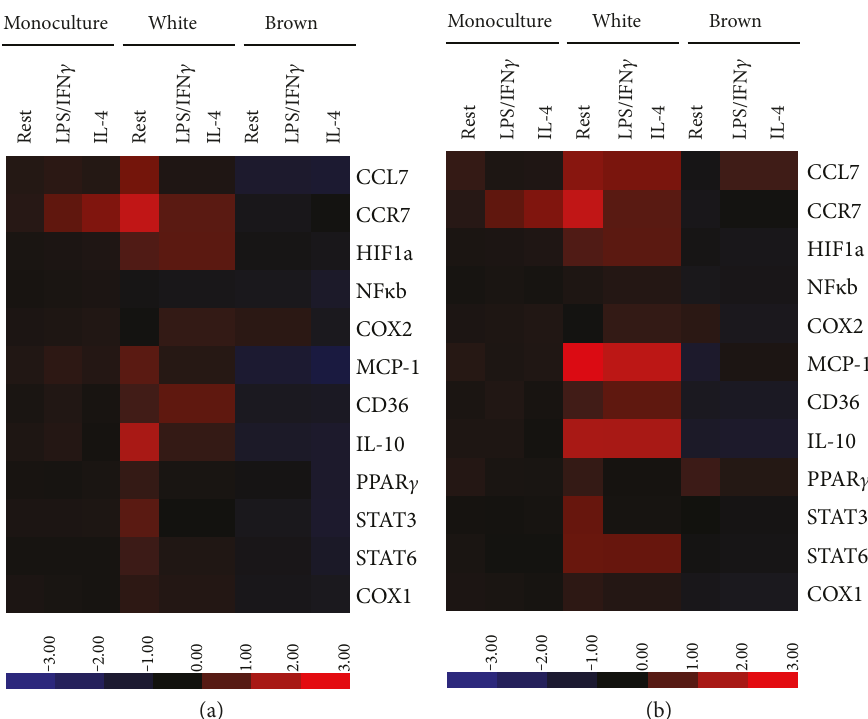
Figure 3: Di ff erential e ff ects of brown and white adipocytes on transcriptional activity. PMA-di ff erentiated macrophages were rested (left untreated) or stimulated with LPS/IFN γ or IL-4 for 24 hours. Cells were then washed and cultured with or without adipocytes for an additional 24 hours (see Section 2 for di ff erentiation and stimulation protocol). qRT-PCR analysis was used to measure expression of a panel of transcripts, which were selected for their role in macrophage in fl ammatory responses (see Section 4 for details). Gene expression of macrophages in adipocyte coculture was normalized to macrophages in monoculture, and the above heat maps illustrate that indirect coculture of U937 and THP-1 macrophages with white adipocytes induces a general increase in transcript expression in U937 (a) and THP-1 macrophages (b). In contrast, coculture with brown adipocytes induces a general reduction in transcript expression. Data represent biological replicates of N = 11 for macrophage monocultures, N = 4 for macrophages cocultured with white adipocytes of the same clone, and N = 6 for macrophages cocultured with brown adipocytes of the same